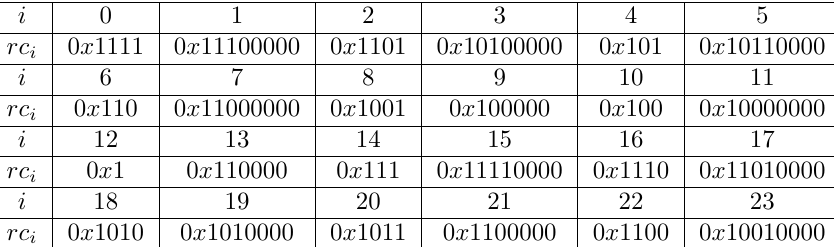
Table 3: Round constants rc i in hexadecimal notation